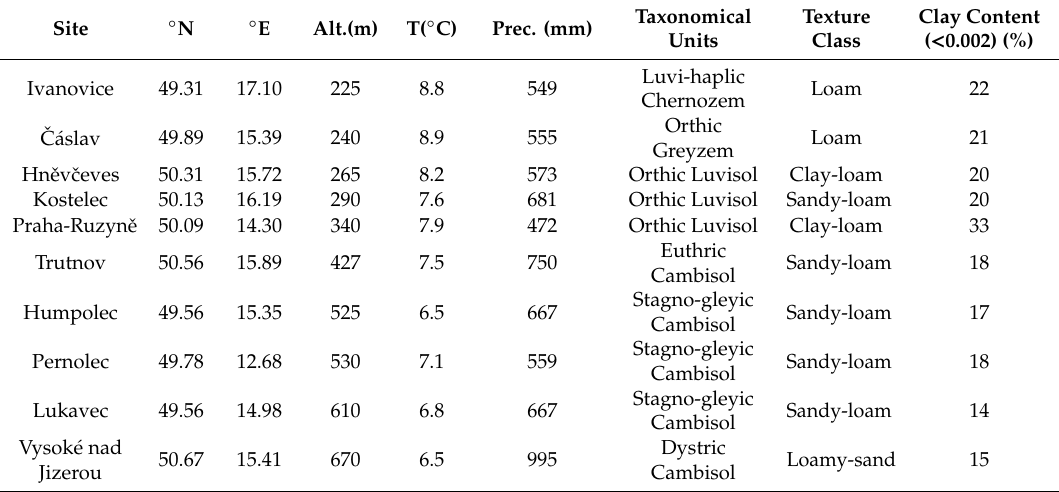
Table 1. Climatic and soil characteristics of the experimental sites.